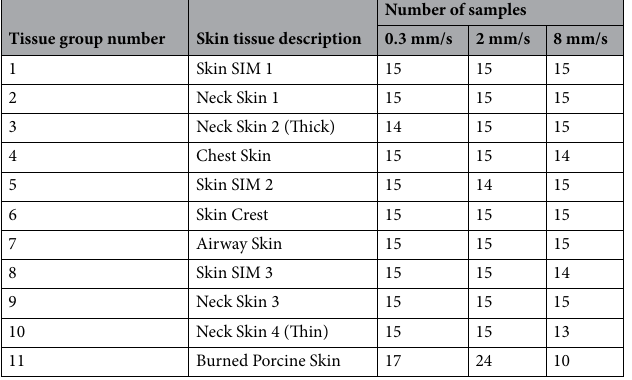
Table 2. Tissue groups and number of samples for the three loading rates after removal of outliers.